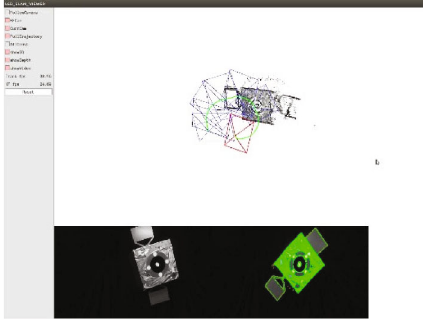
Figure 14: Schematic diagram of the running process of the